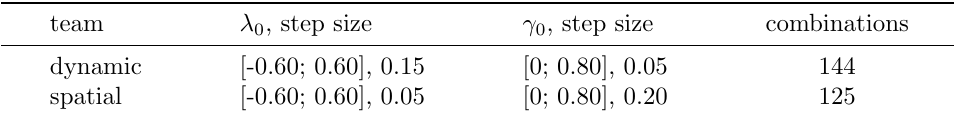
Table 2: Parameter